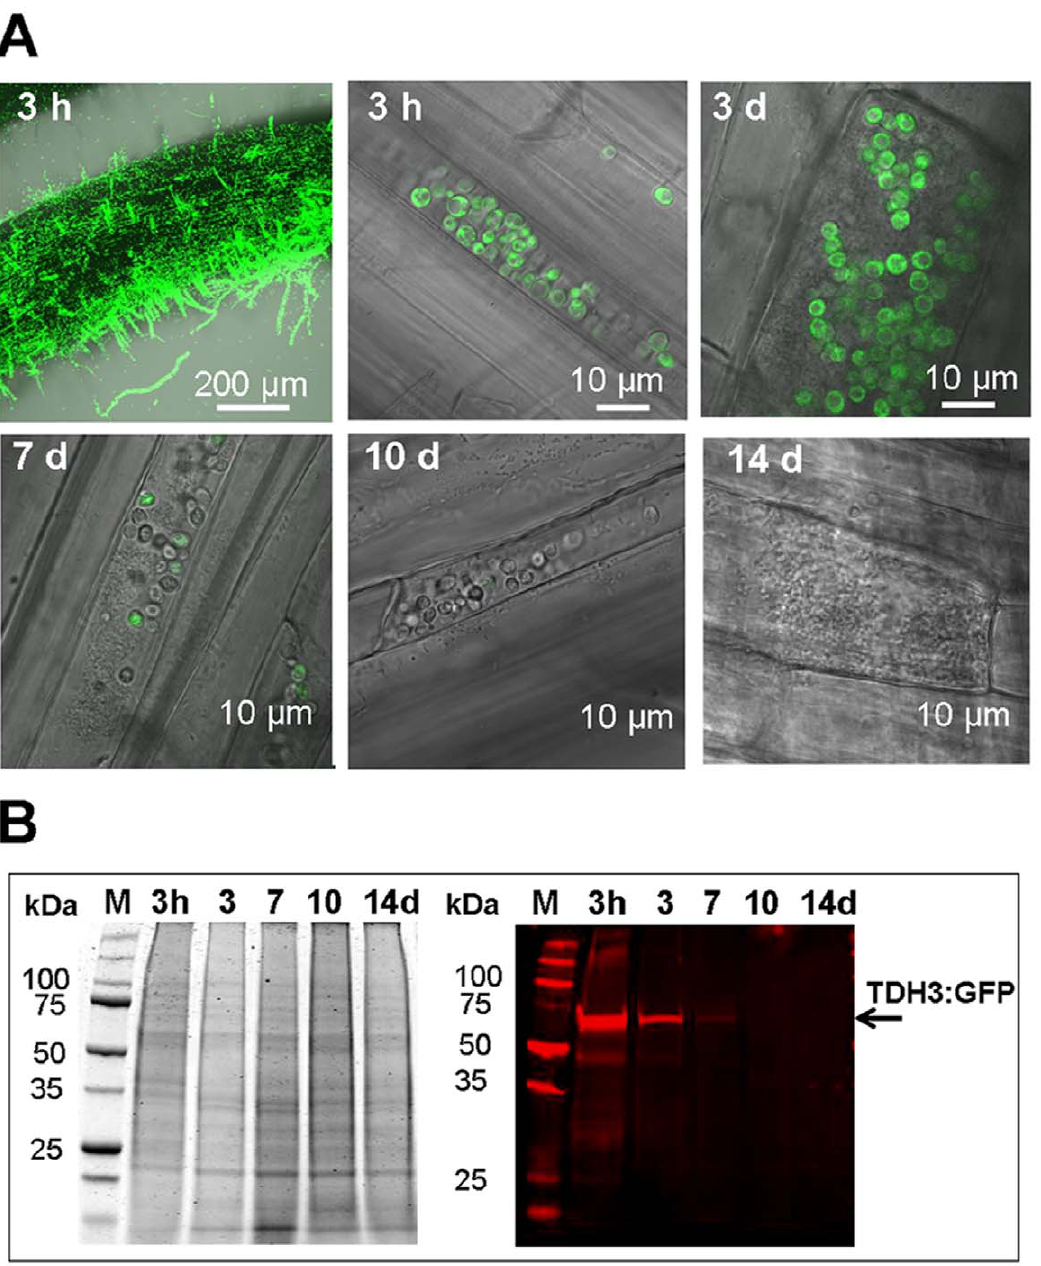
Figure 3. Time course experiment of yeast degradation in tomato roots. (A) The number of living yeast cells (fluorescing green) in tomato decreased over time as observed by CLSM. (B) The amount of recombinant TDH3:GFP protein present inside the roots 0decreased over time. Equal amounts of proteins from root extracts were separated by SDS-PAGE (B, Left) and analyzed by western blot using anti-GFP antibody to detect yeast recombinant TDH3:GFP protein (B, Right).